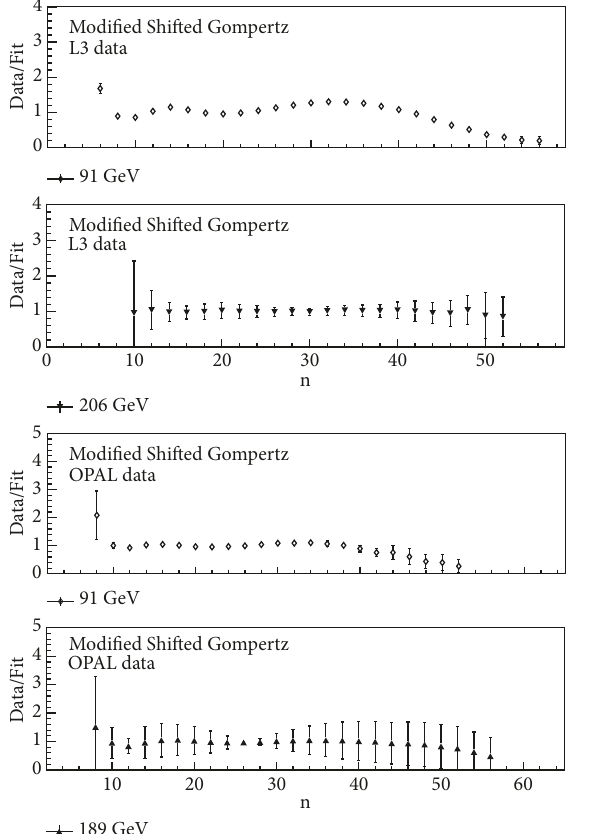
Figure 3: Ratio plots of data over modified shifted Gompertz fit values.